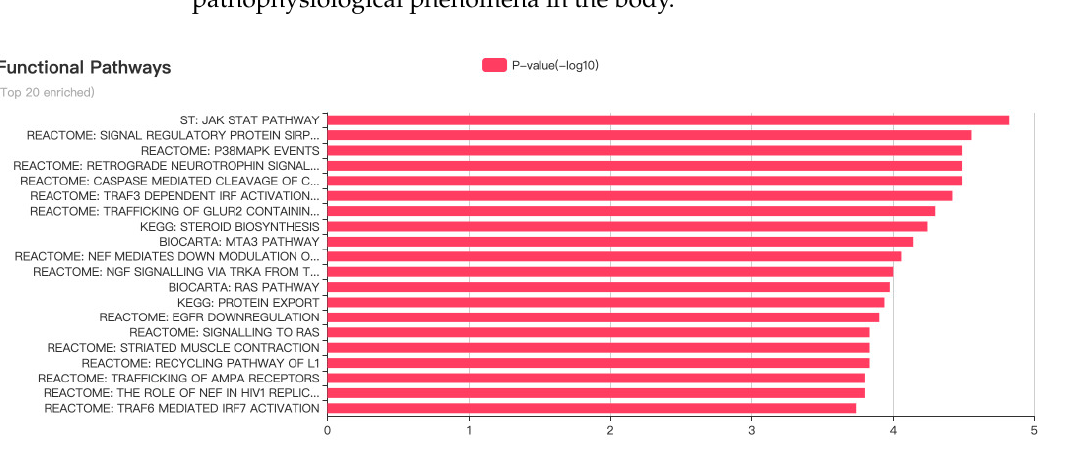
Figure 4. Ten important pathways through which MALAT1 functions.